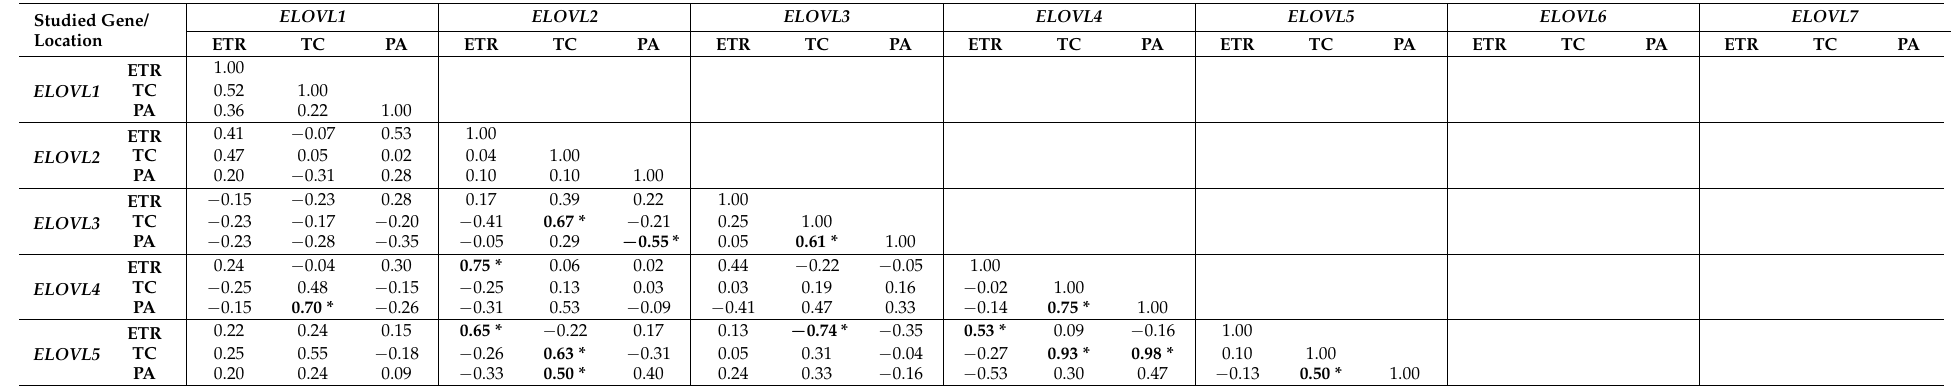
Table 4. Mutual correlations between the expression of the studied elongases, and correlations between the expression of the elongases and GBM tumor regions in